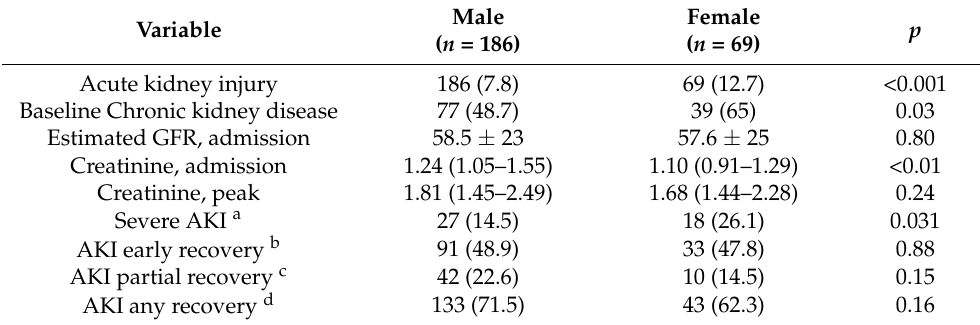
Table 2. Renal outcomes among patients with acute kidney injury, compared by gender.